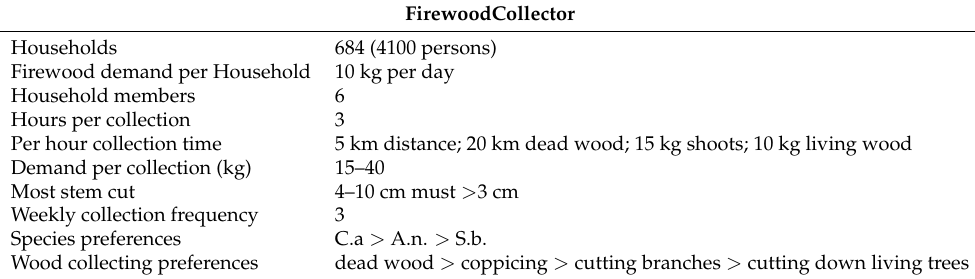
Table 2. Firewood collector parameters.